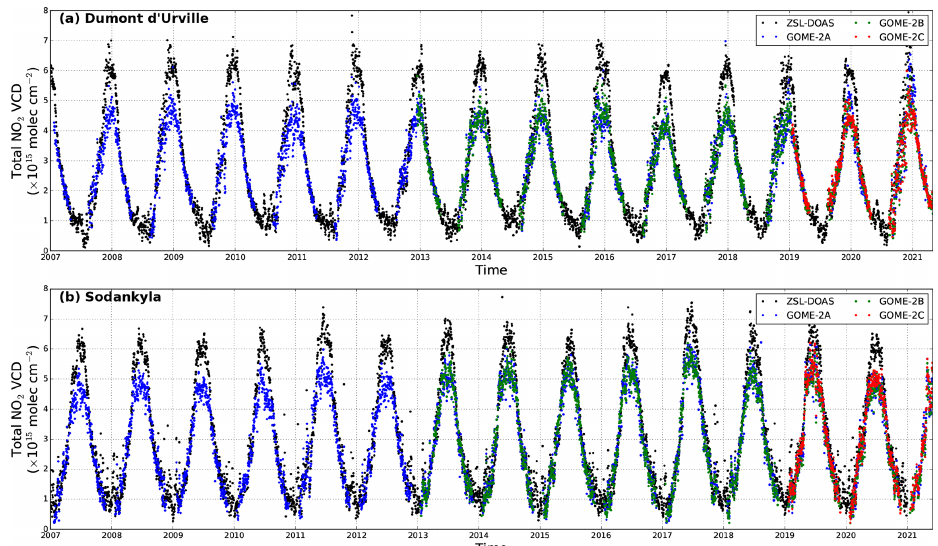
Figure 15. Time series of total column NO 2 measured by GOME-2A (blue), GOME-2B (green), GOME-2C (red), and ZSL-DOAS (black). Observations over (a) Dumont d’Urville, Antarctica, and (b) Sodankylä, Finland, are shown.